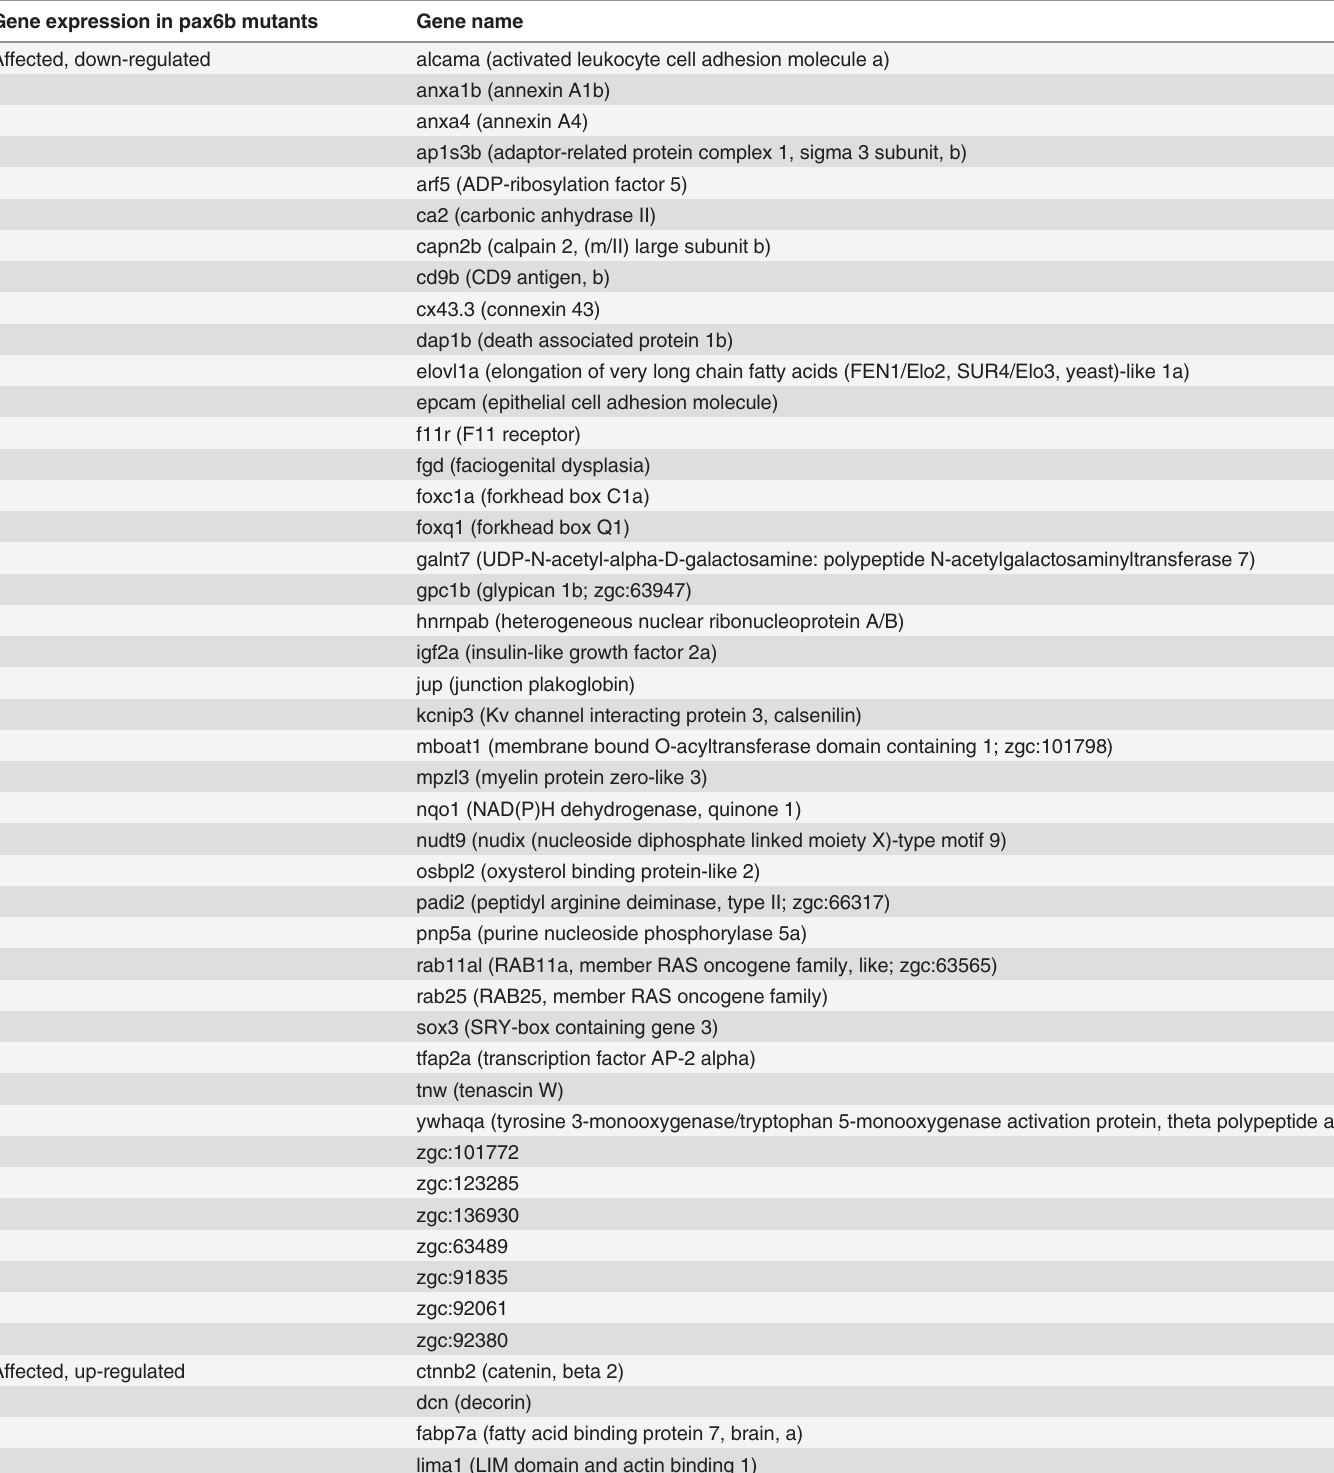
Table 2. Corneal gene expression in sunrise/pax6b mutants in comparison to wildtype embryos. Gene expression in pax6b